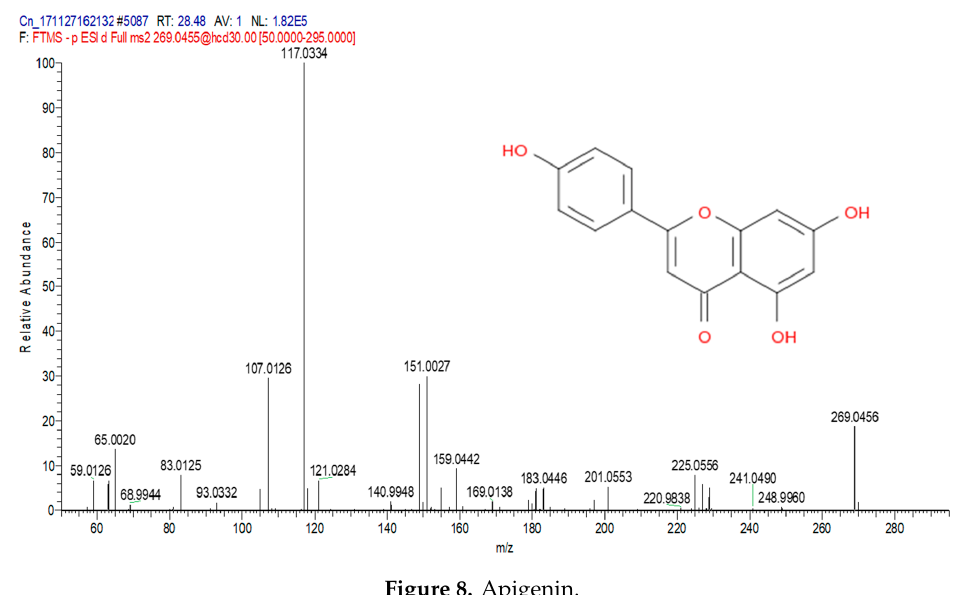
Figure 8. Apigenin. Figure 8. Apigenin.